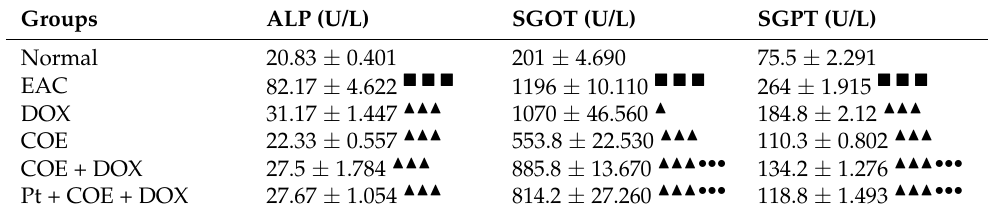
Table 4. Effect of COE on hepatic enzymes.